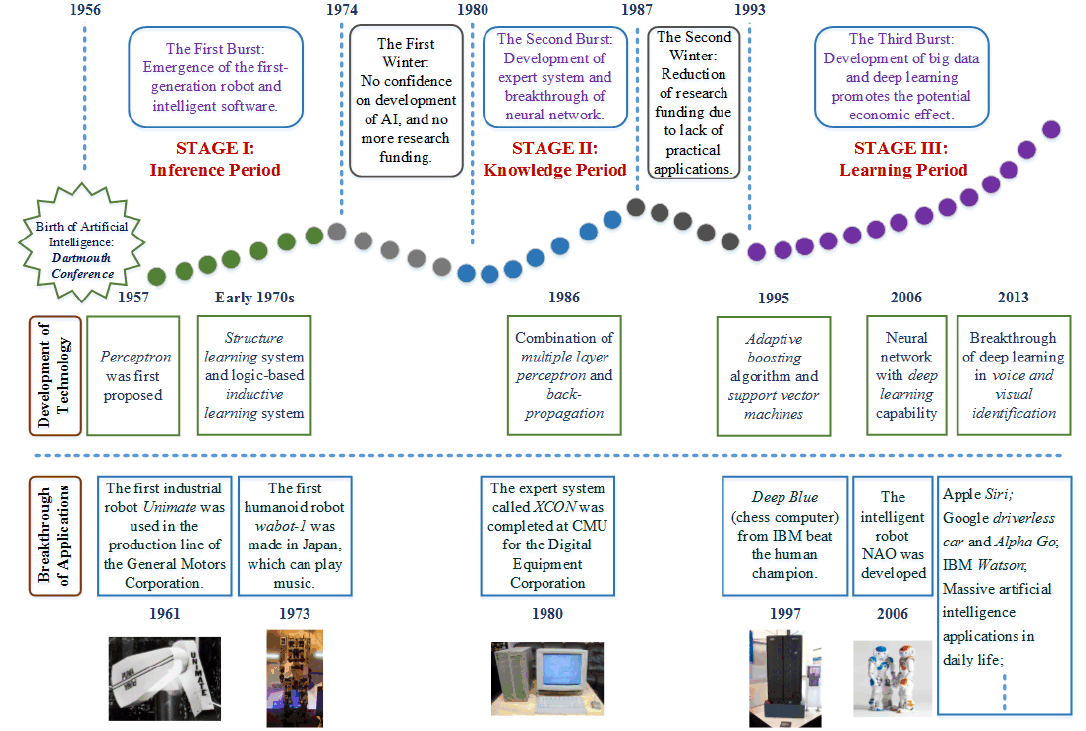
Figure 8. Development history of artificial intelligence